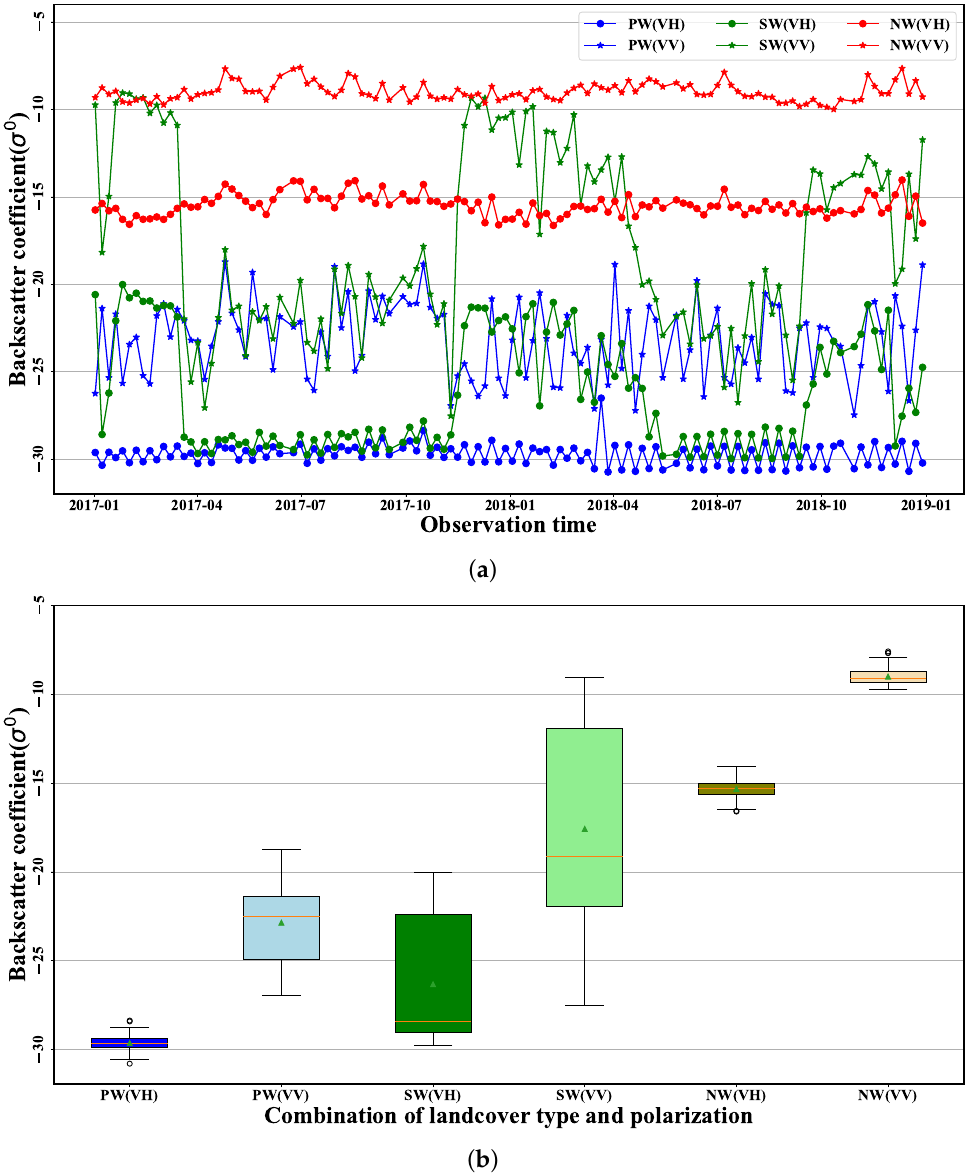
Figure 9. The temporal variations in radar backscatter coefficient from Sentinel-1 SAR data for different land cover types and polarization. PW is for persistent water area, SW is for seasonal water area, and NW is for non-water